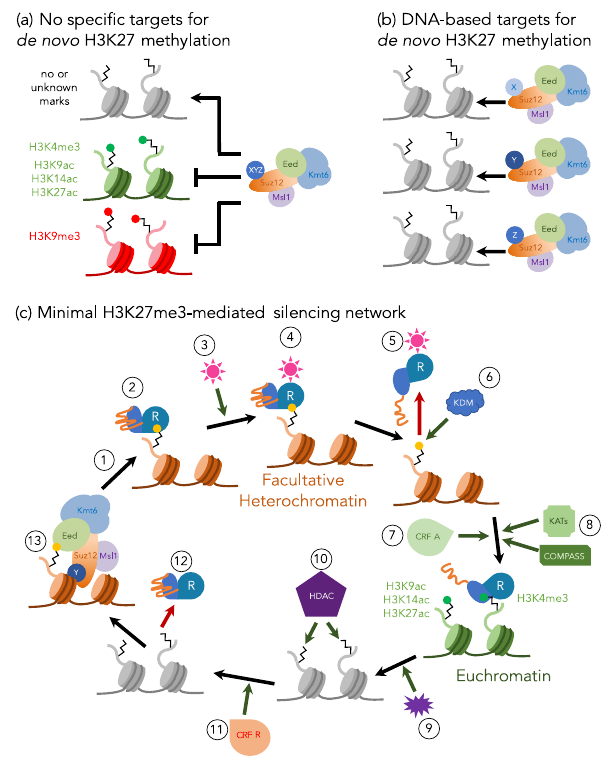
Figure 2. Working models for de novo H3K27 methylation and a minimal